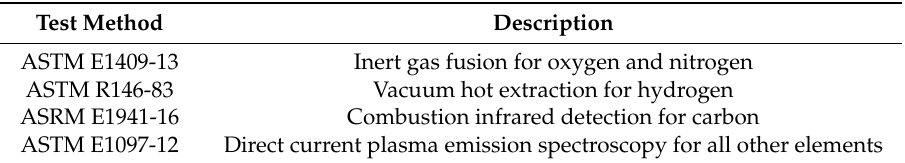
Table 2. ASTM 2063 test method description.